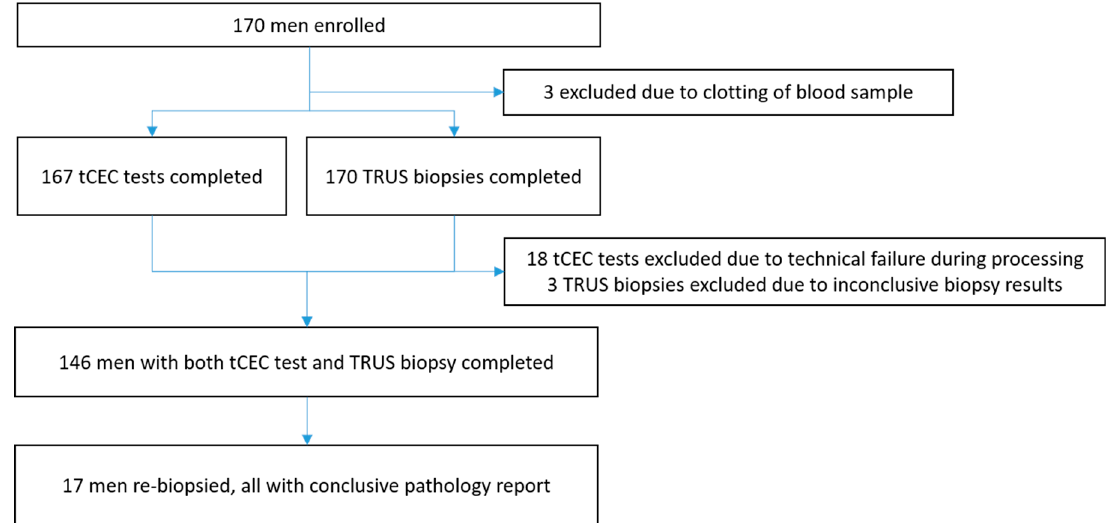
Figure 1. Trial flow diagram. tCEC: tumour-associated circulating endothelial cells; TRUS biopsy: transrectal ultrasound-guided biopsy.